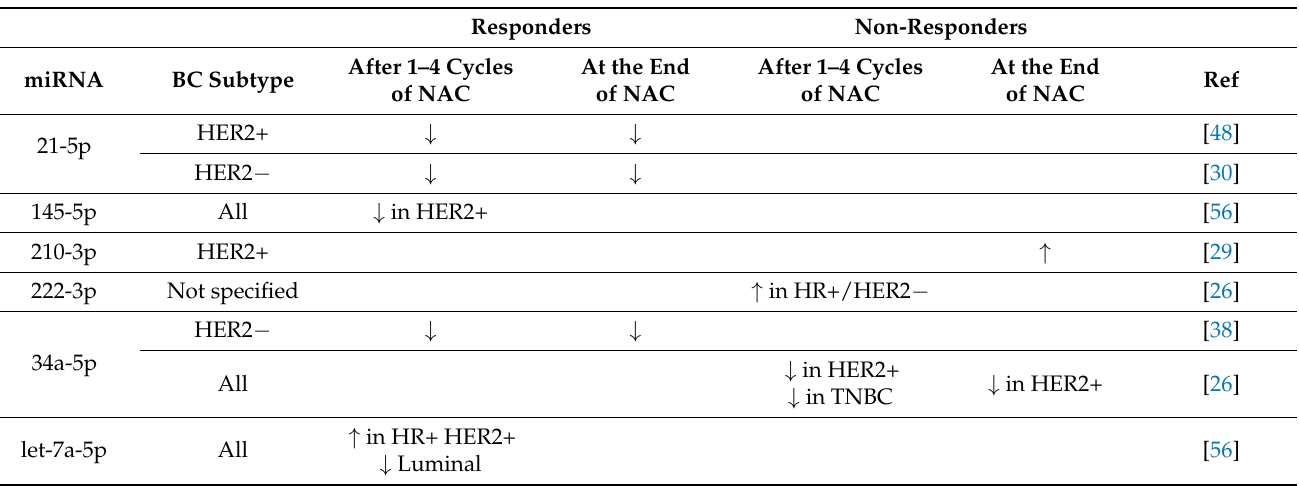
Table 3. Statistically significant dynamic changes in circulating miRNA levels in BC patients under- going NAC and association with response to treatment ( p < 0.05). Up arrow indicates increased level from baseline. Down arrow indicates decreased level from baseline.